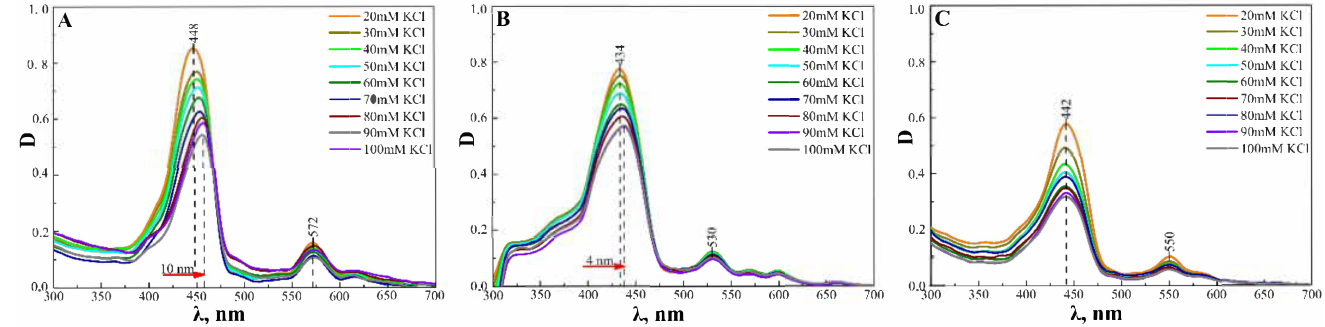
Figure 3. UV–Vis spectra of porphyrins in water solution (2mM HEPES, pH 7) upon increase in the concentrations of KCl for: ( A ) 4 µ M of Zn-1 ; ( B ) 4 µ M of 2H-1 ; ( C ) 6 µ M of Ni-1